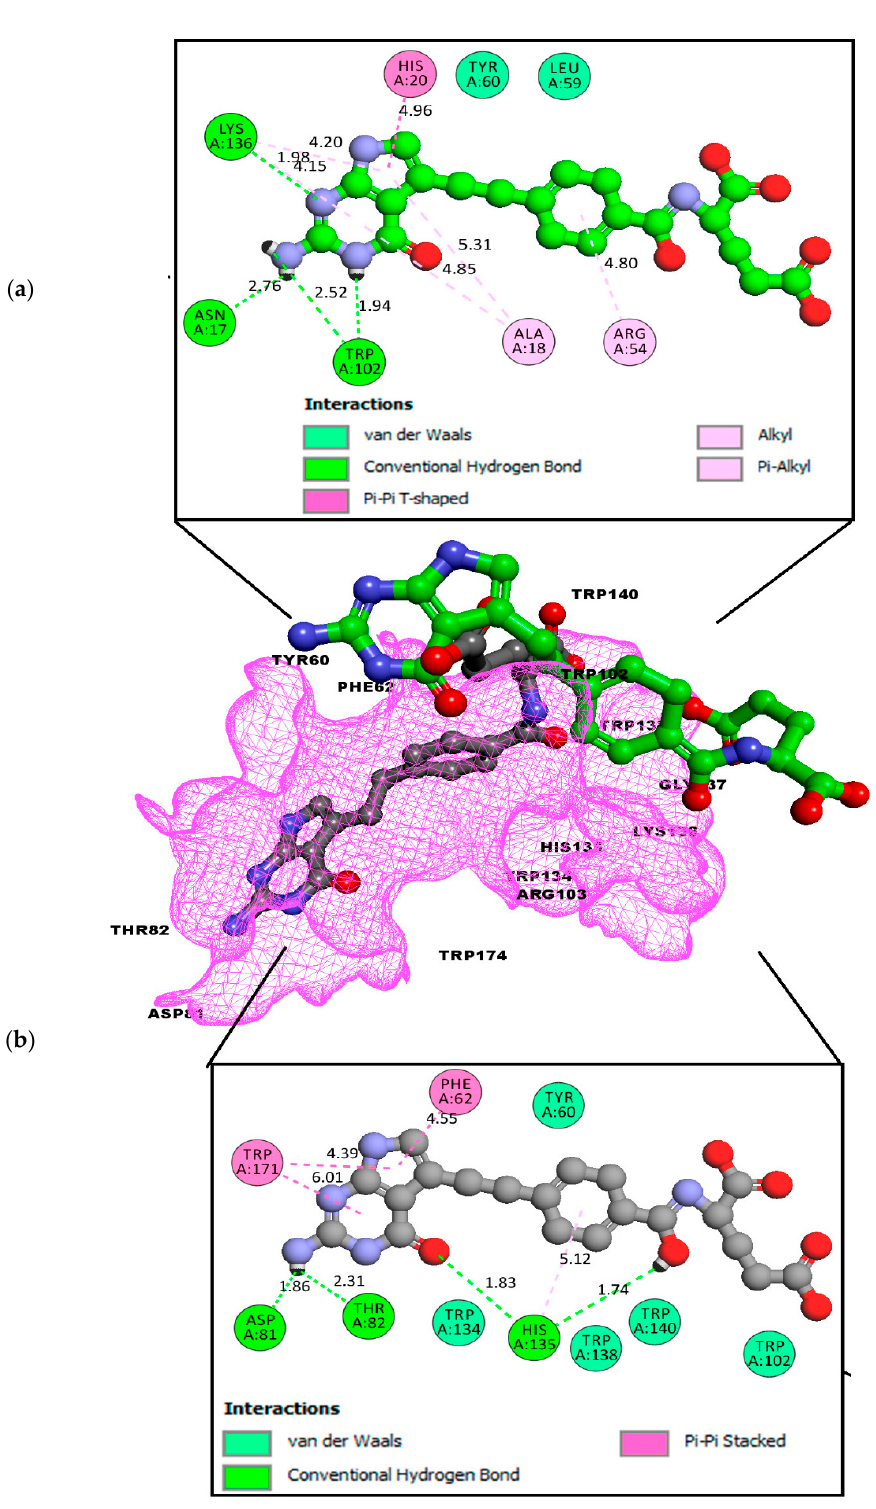
Figure 9. The FR α as extracted from the selected frames at ( a ) 82 ns and ( b ) 30 ns, from the 100 ns MD simulations. These models demonstrate how PTX left the binding pocket of FR α (pink) after losing the interaction with ASP81 at 82 ns.